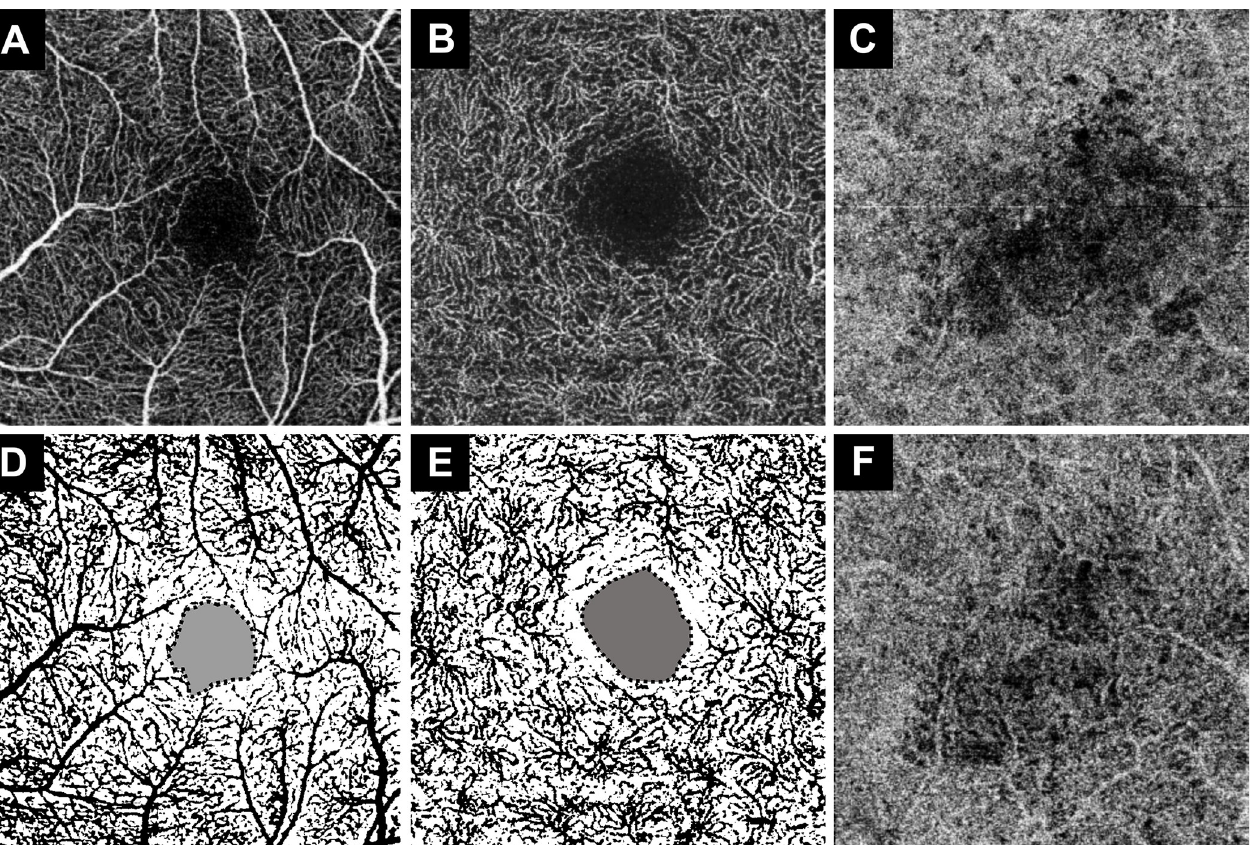
Fig 1. The analysis process of the en-face OCTA image. The 3 mm × 3 mm-sized en-face image of the SCP (A) and DCP (B) was converted to a binarized image (D and E) using ImageJ software. From the binarized image, the FAZ area (black dotted grayish area) was measured at the center, and the black colored vessel area was measured. Vessel density was obtained by dividing the vessel area by the area where the FAZ area was removed by 9 mm 2 . The signal void (F) of the choriocapillaris at 6 months post-PDT is smaller than the signal void (C) of the choriocapillaris after the subretinal fluid was completely absorbed 1 month